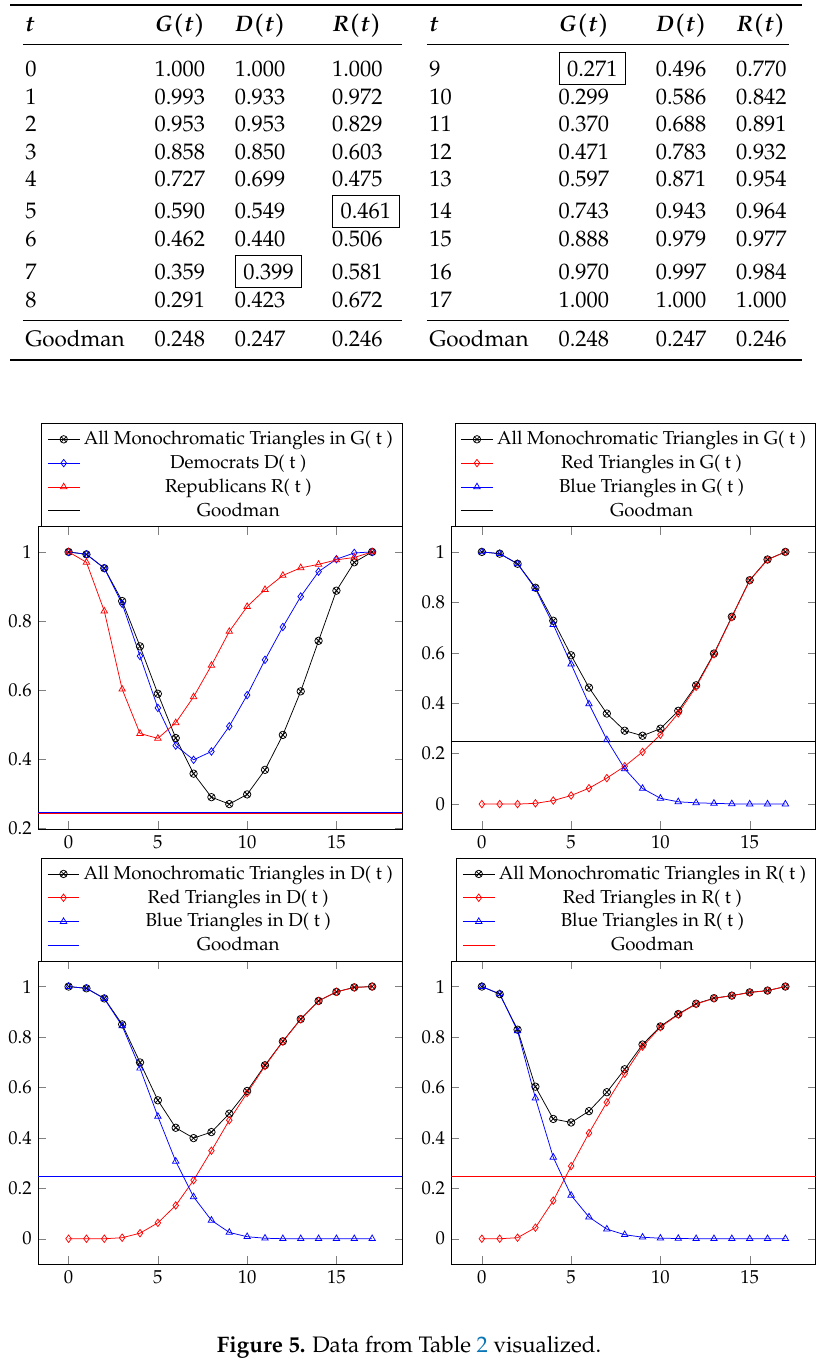
Table 2. The percentage of monochromatic triangles for various threshold graphs. The minimum values are boxed.